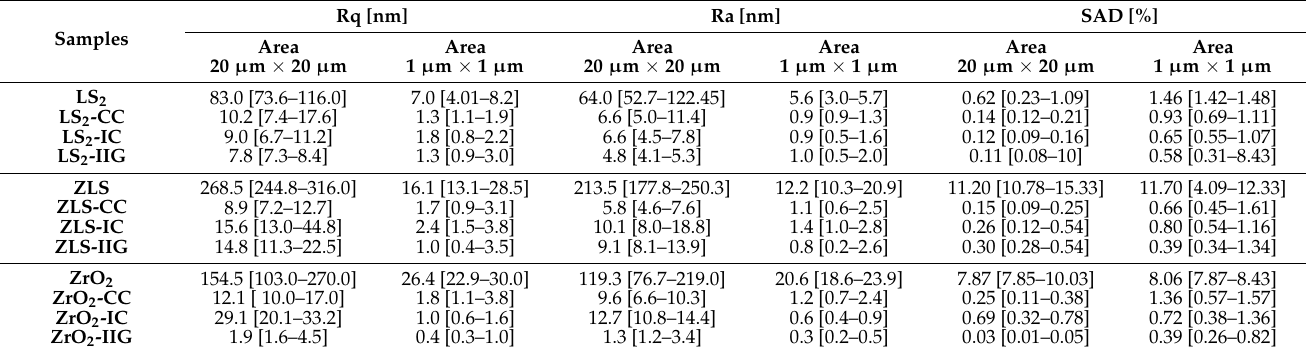
Figure 1. AFM 2D images (area 20 µ m × 20 µ m) of the tested ceramic surfaces before and after glazing. Table 2. The surface roughness of the tested